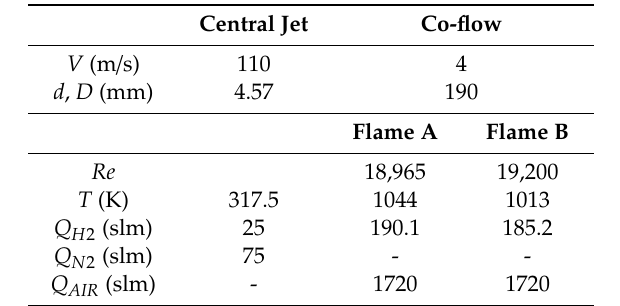
Table 2. Experimental conditions for lifted H 2 / N 2 jet flame [23] ( V : Velocity; T : Temperature; d , D : Diameters of central and annular jets; Re : Reynolds number; Q i : Volume flow rates).